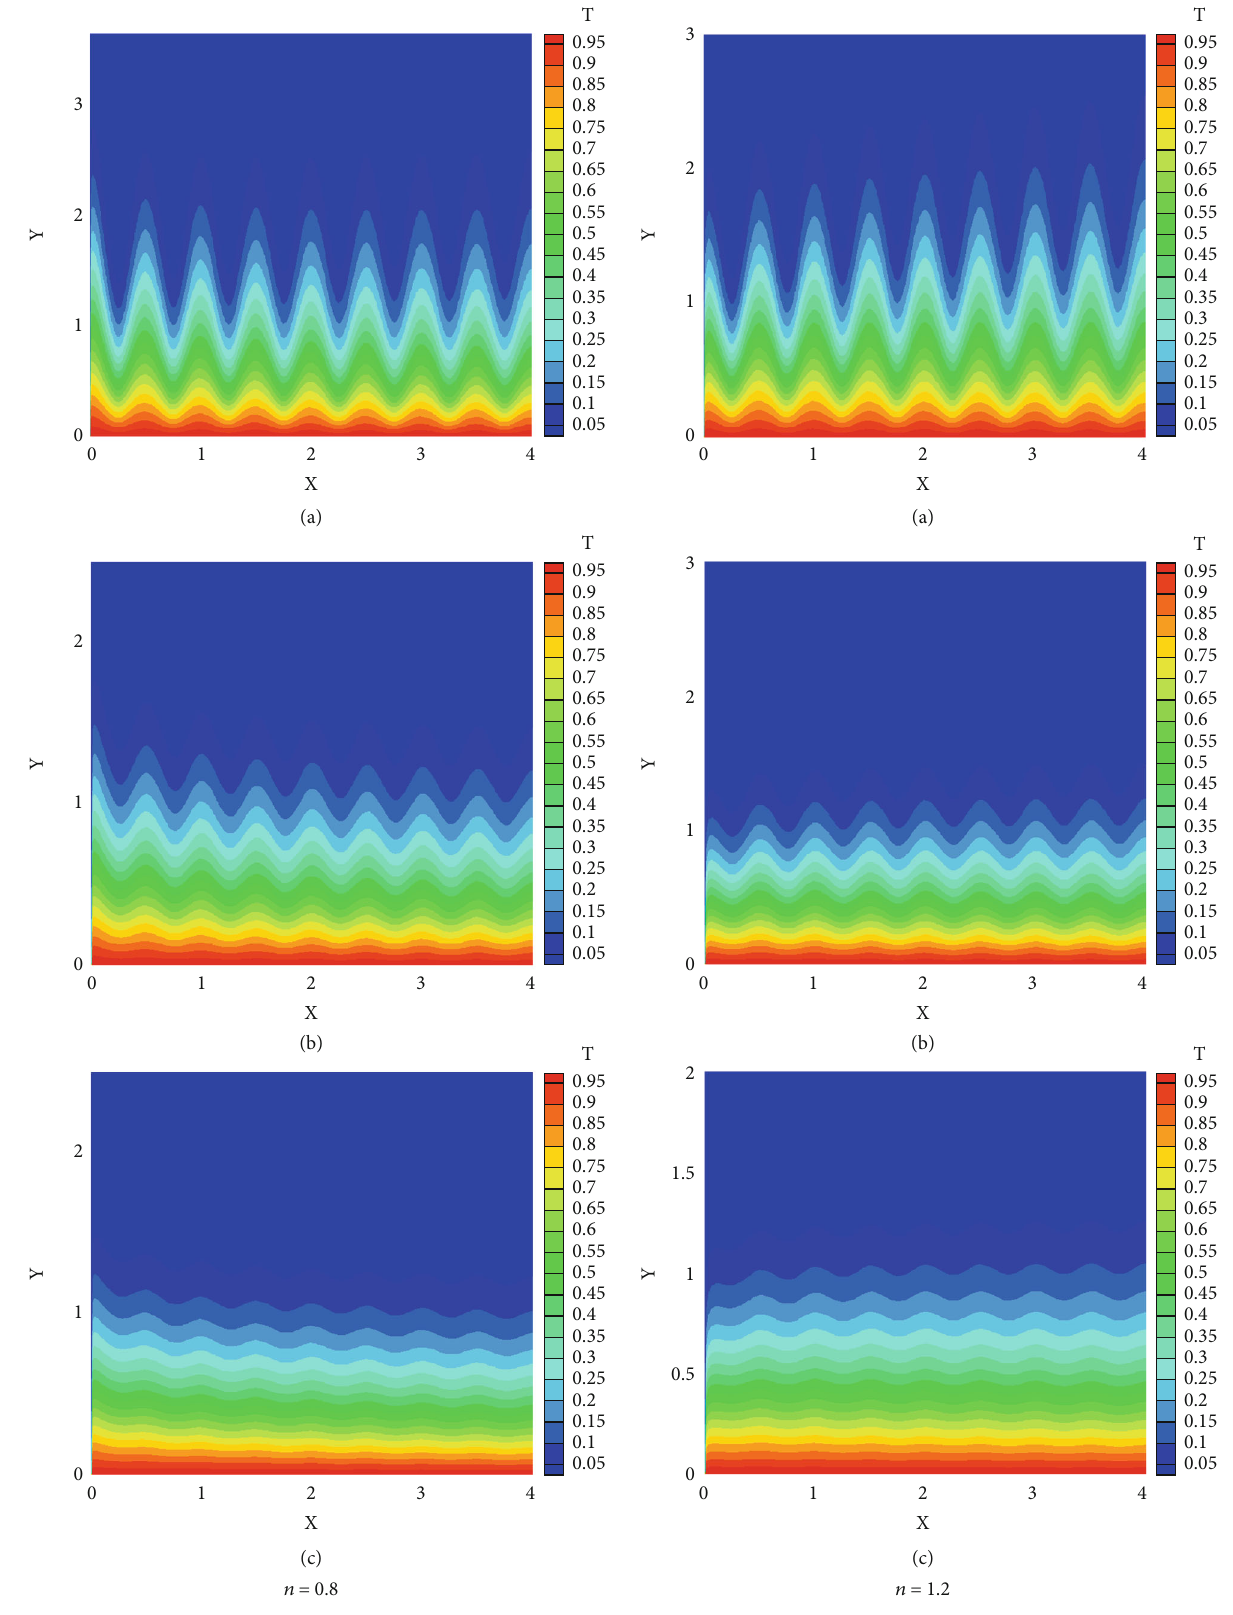
Figure 14: Temperature contour for Pr